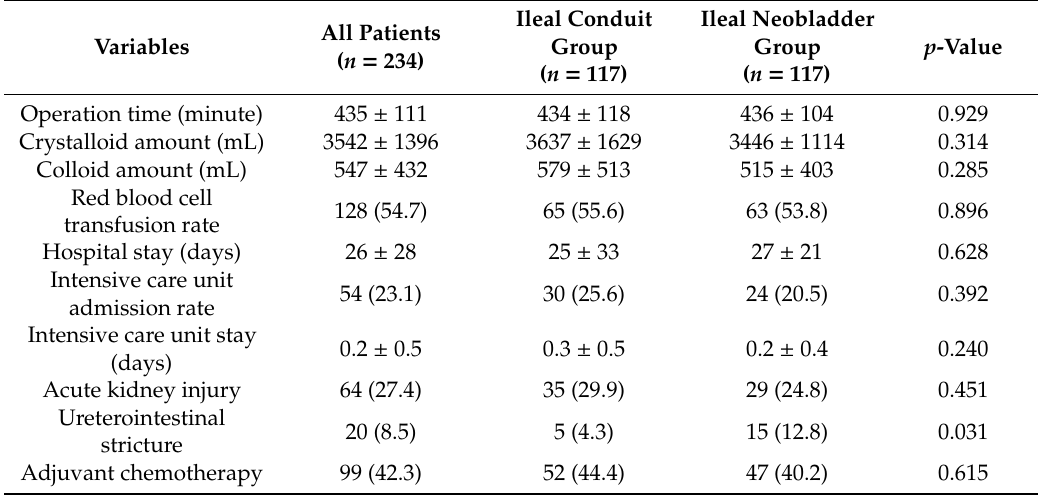
Table 2. Intraoperative data and postoperative outcomes after propensity score matching.